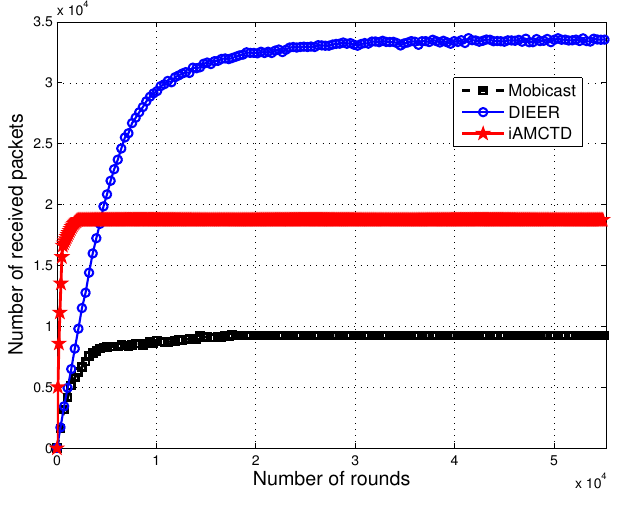
Figure 9. Network